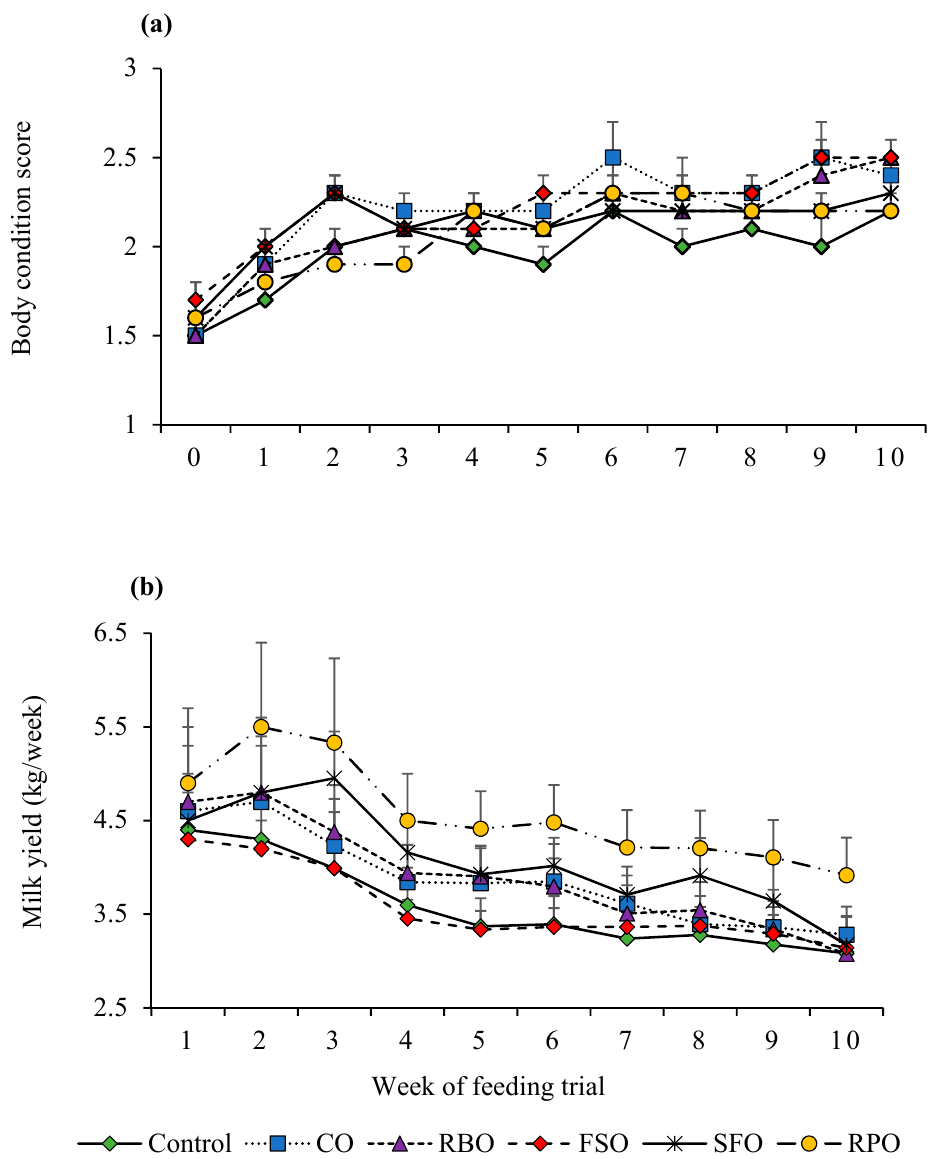
Figure 1. Weekly trends in body condition score ( a ) and milk yield ( b ). Canola oil (CO), rice bran oil (RBO), flaxseed oil (FSO), safflower oil (SFO), rumen-protected oil (RPO).